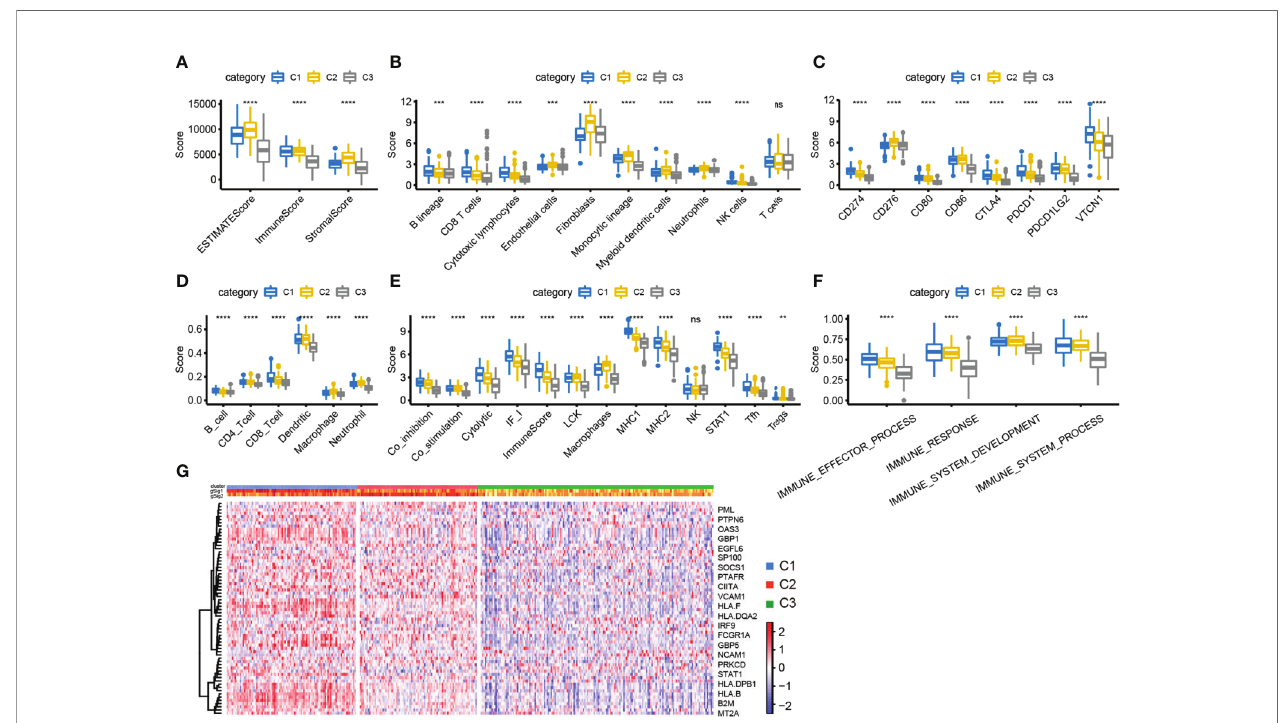
FIGURE 5 | Analysis of immune characteristics of immune subtypes. (A) The box plot of immune score difference in each subtype was calculated by ESTIMATE. (B) The box plot of 10 immune components difference in each subtype was calculated by MCPcounter. (C) The expression differences of 8 common immune checkpoint genes among three subtypes. (D) The difference of 6 kinds of immune cell scores in each subtype. (E) The differences of 13 kinds of immune components in different subtypes. (F) Differences of enrichment scores of four immune pathways among three subtypes. (G) Differential expression of IFN- g related regulatory genes in three immune subtypes. **P < 0.01, ****P < 0.0001, and ns, ‘ No Signi fi cant ’